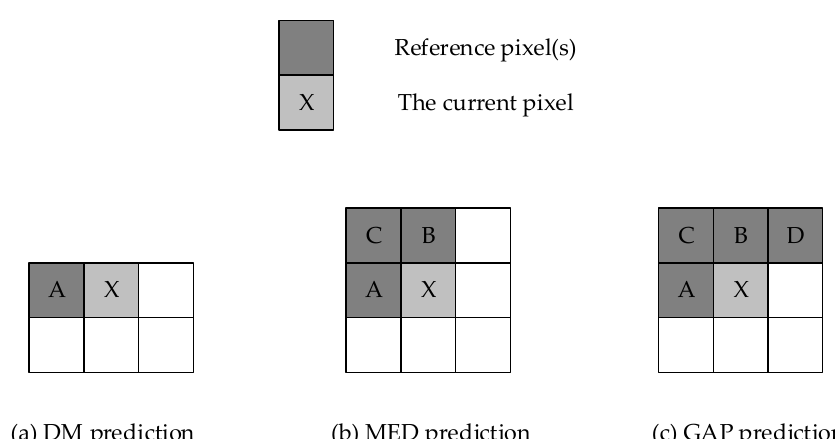
Figure 3. Reference pixels for each prediction algorithm. Abbreviations: DM, delta modulation; MED, median edge detection; GAP, gradient adaptive prediction. ( a ) Delta modulation prediction uses one neighborhood pixel; ( b ) MED prediction uses three neighborhood pixels; ( c ) GAP prediction uses four neighborhood pixels. Table 3. CR comparison according to the prediction algorithm.